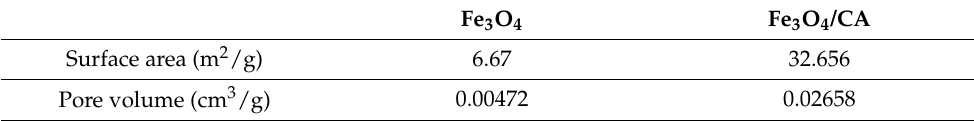
Table 3. Fe 3 O 4 and Fe 3 O 4 /CA textural